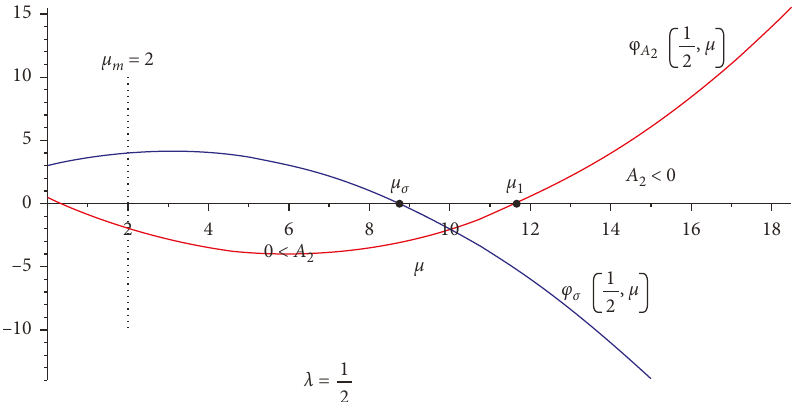
Figure 3: Curves of functions φ